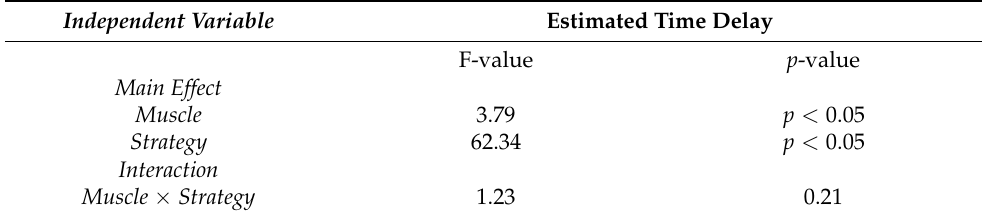
Table 3. ANOVA analysis result.